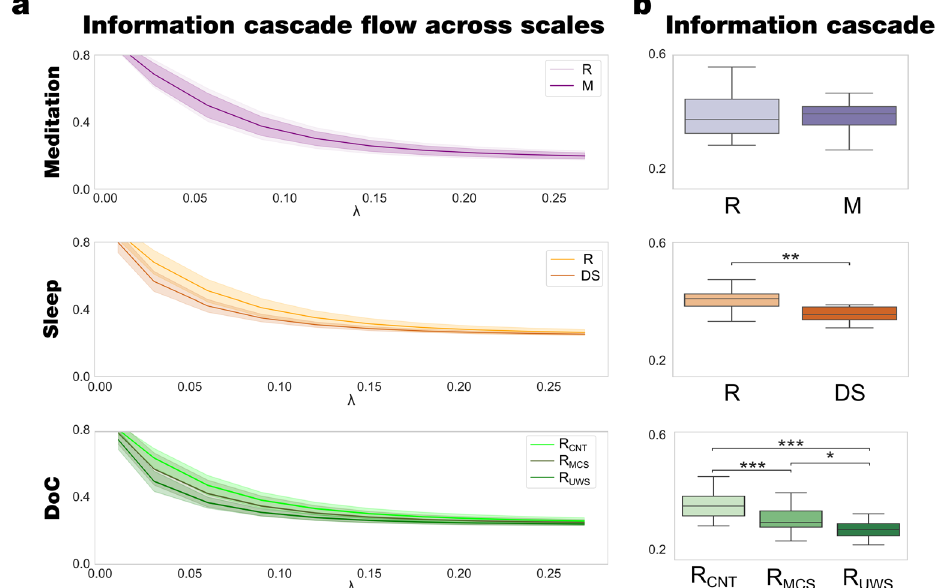
Fig. 3 Model-free framework showed differences in information cascade fl ow and information cascade in different brain states. a The information cascade fl ow across scales is the predictability given by the level of synchronisation at a speci fi c scale ( λ ) from the previous scale λ − Δ λ (where Δ λ = 0.03 is the discretisation of scale). The meditation state presents no differences across the scales compared to the resting state, the information cascade fl ow signi fi cantly decreases for DS and R MCS , R UWS states compared to the resting across all scales. b The information cascade, de fi ned as the average information cascade fl ow, differentiates R MCS , R UWS , and DS states from the resting state, while the meditation state presents no differences. P-values were assessed using the Wilcoxon rank-sum test and corrected for multiple comparisons, * P < 0.05, ** P < 0.01 and *** P <